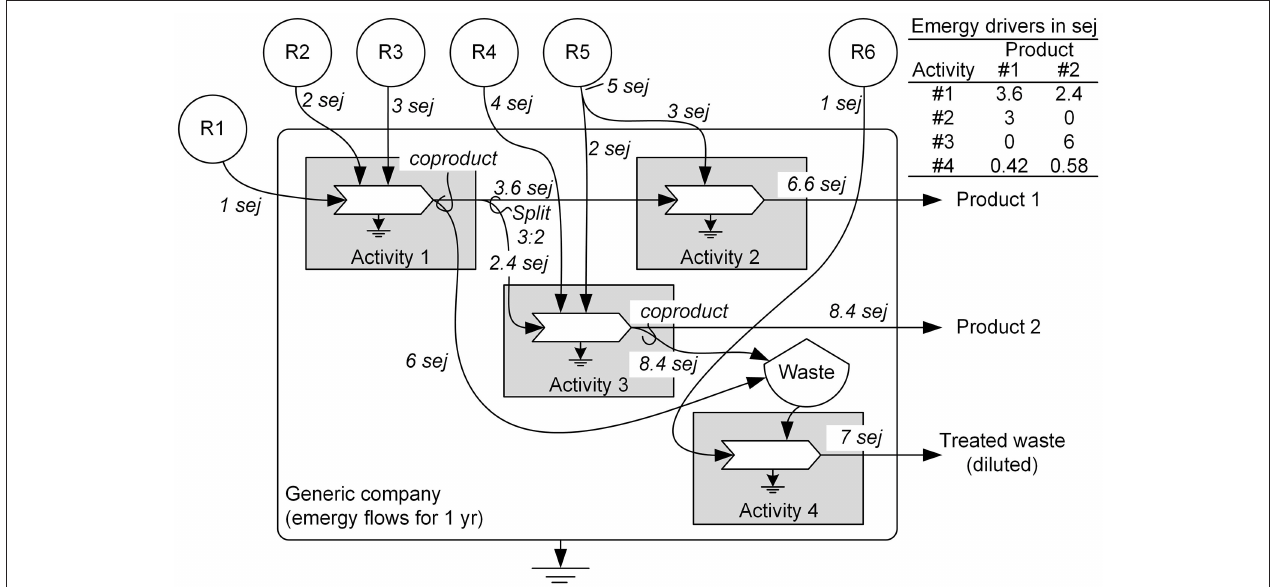
FIGURE 3 | Energy diagram of a generic company to exemplify the emergy-based drivers calculation. R, external resources.